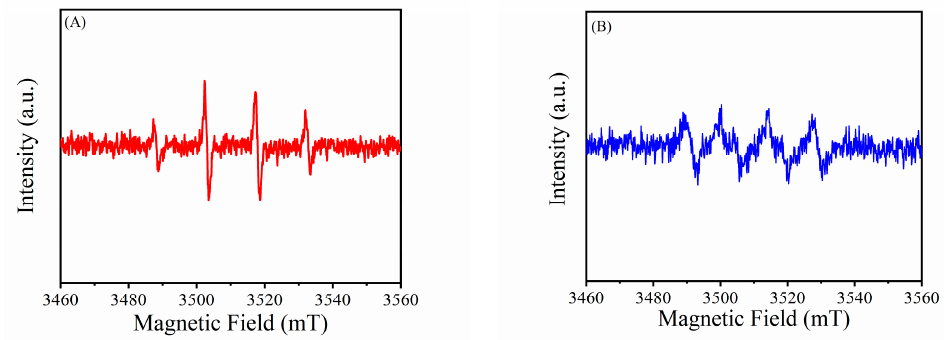
Figure 4. ESR spectrum of the MVCM-H 2 O 2 system treated with DMPO. ( A ) ESR spectra of DMPO- · OH; ( B ) ESR spectra of DMPO- · O